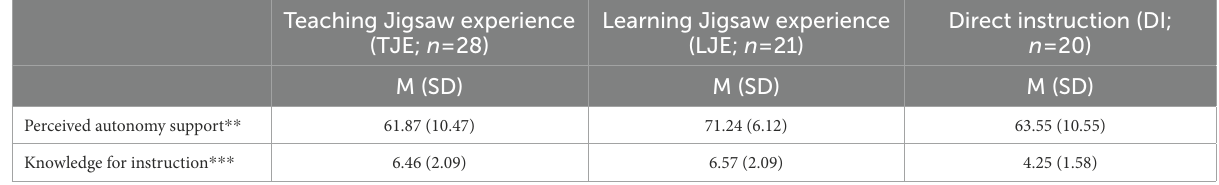
TABLE 1 Means (and standard deviations) for perceived autonomy support, and knowledge for instruction by training type conditions ( N =